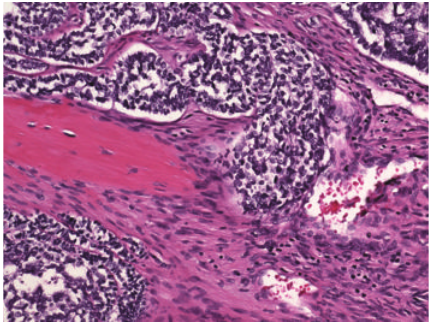
Figure 6: Histological preparation (200x magnification, H-E stain) which shows basaloid, epithelial cell groups intermingled with a fibrous spindle cell component.